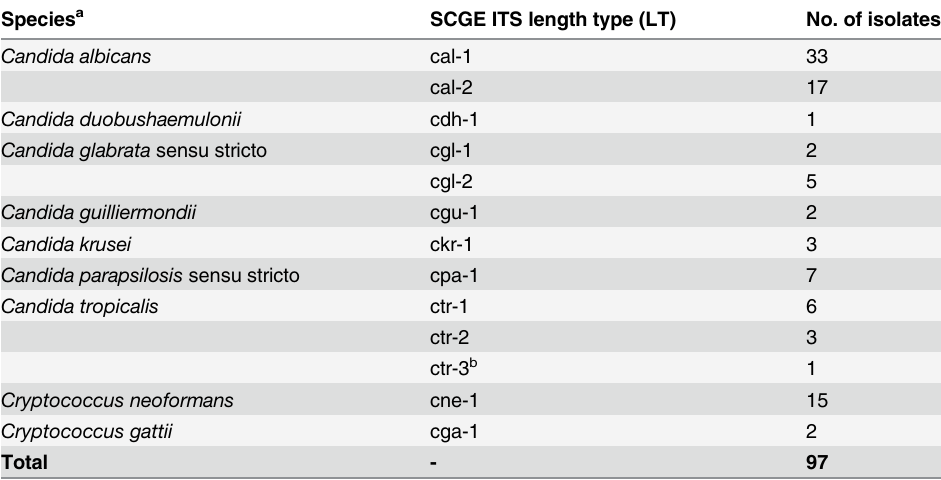
Table 2. The results of isolates collected from PUMCH in 2013 by SCGE. Species